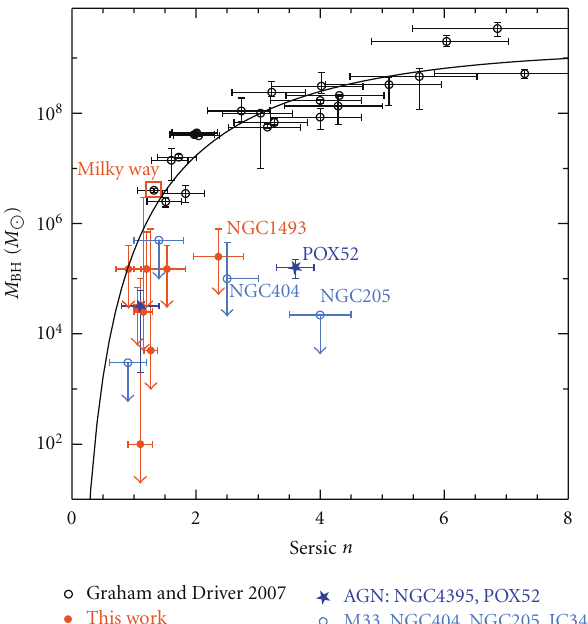
Figure 4: The mass of the BH against the Sersic index of the host bulge or disk. We plot the objects as listed in the text. The largest outliers are NGC205 (with n = 4), POX52 ( n = 3 . 6), NGC404 ( n = 2 . 5), and NGC1493 ( n = 2 . 4).